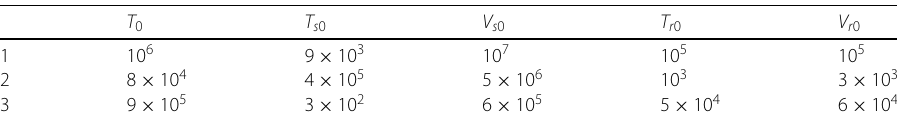
Table 3 Initial values of model